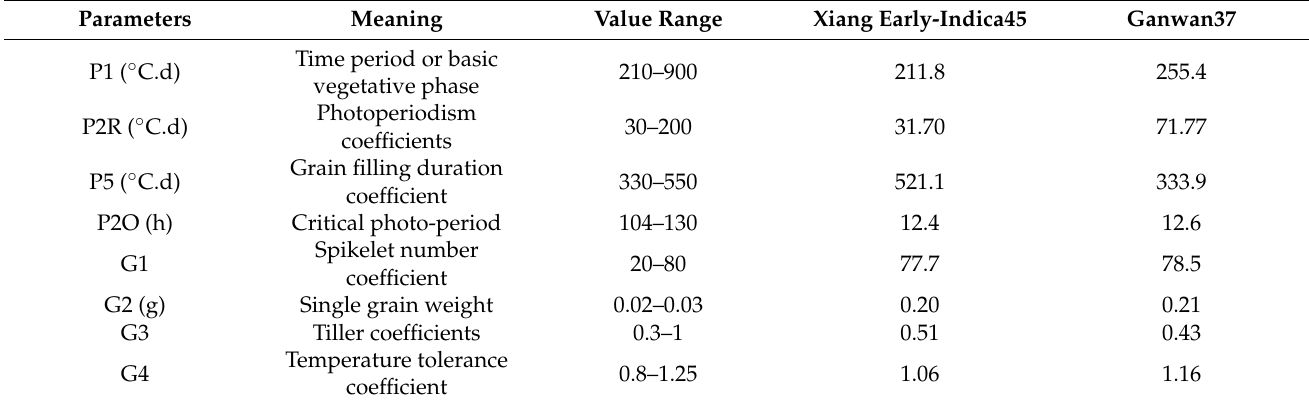
Table 2. Calibrated genetic coefficient values for double-harvest